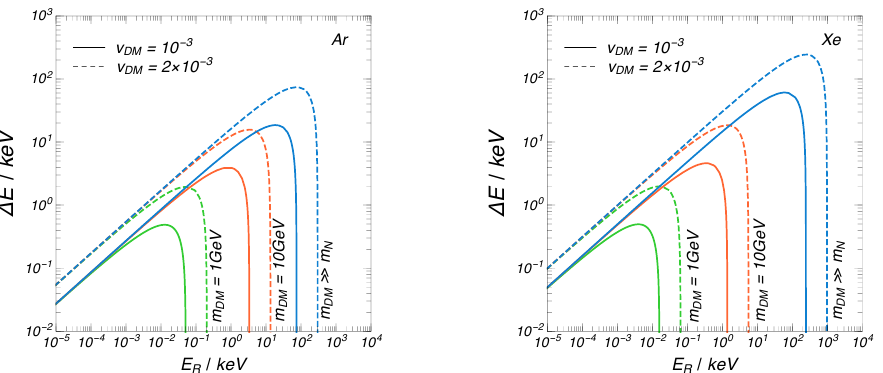
Figure 2 . Kinematical constraints on the plane of ( E R ; (cid:1)E ) for given m DM and v DM for Ar and Xe atoms. The regions below the lines are kinematically